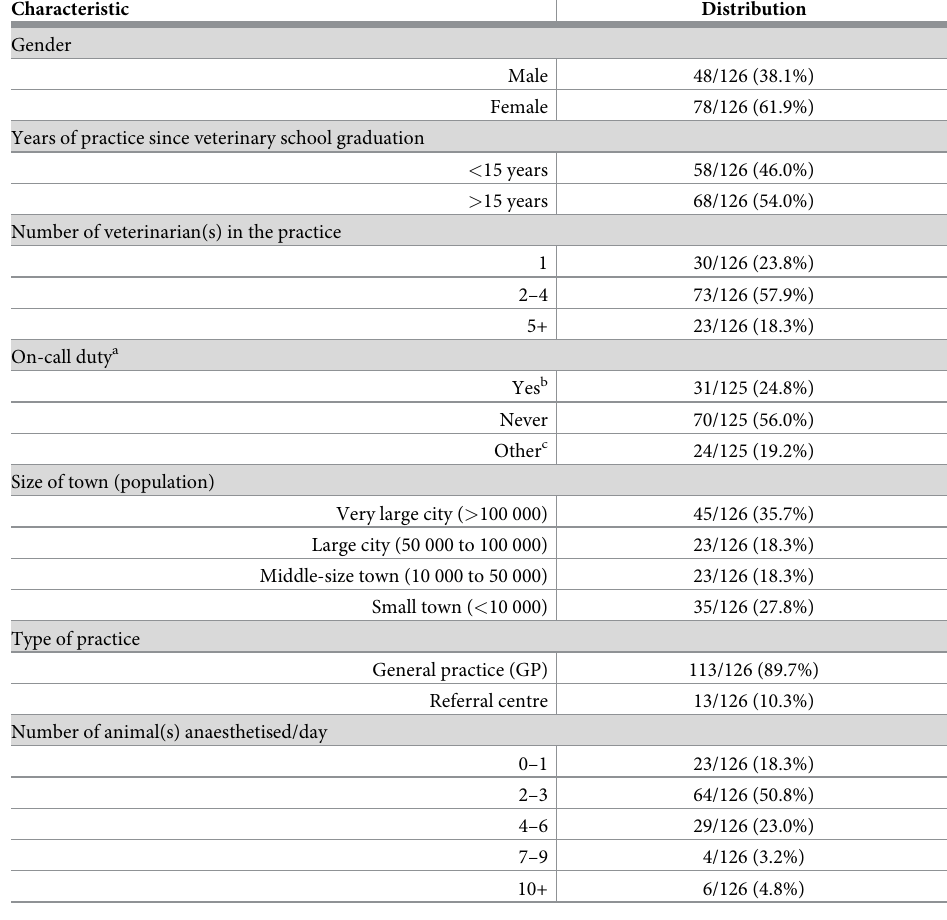
Table 1. Demographic characteristics of English-speaking veterinarians (n = 126) responding to a survey on man- agement of anaesthesia in small animal practices in